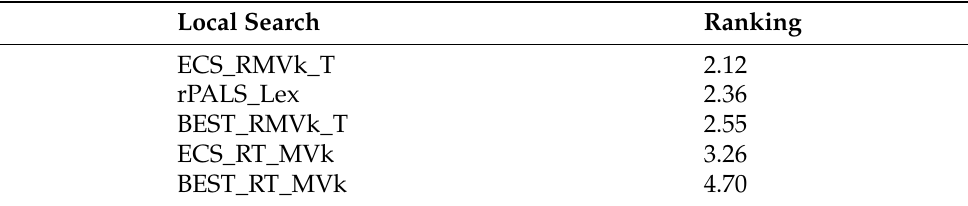
Table 11. Makespan Friedman ranking on the 400 scheduling problems